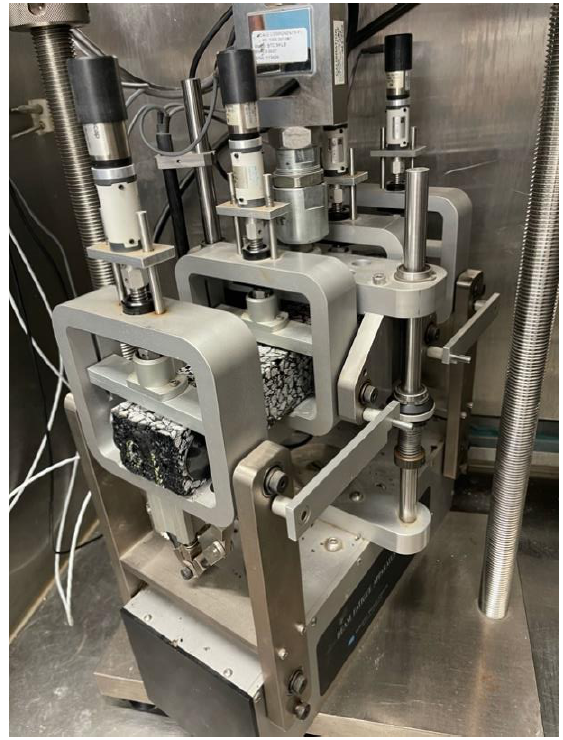
Figure 4. Four-point beam bending test. Table 10. Four-point beam bending test parameters from AG:PT/T233 Reprinted from ref. [17]. Four-Point Beam Bending Test